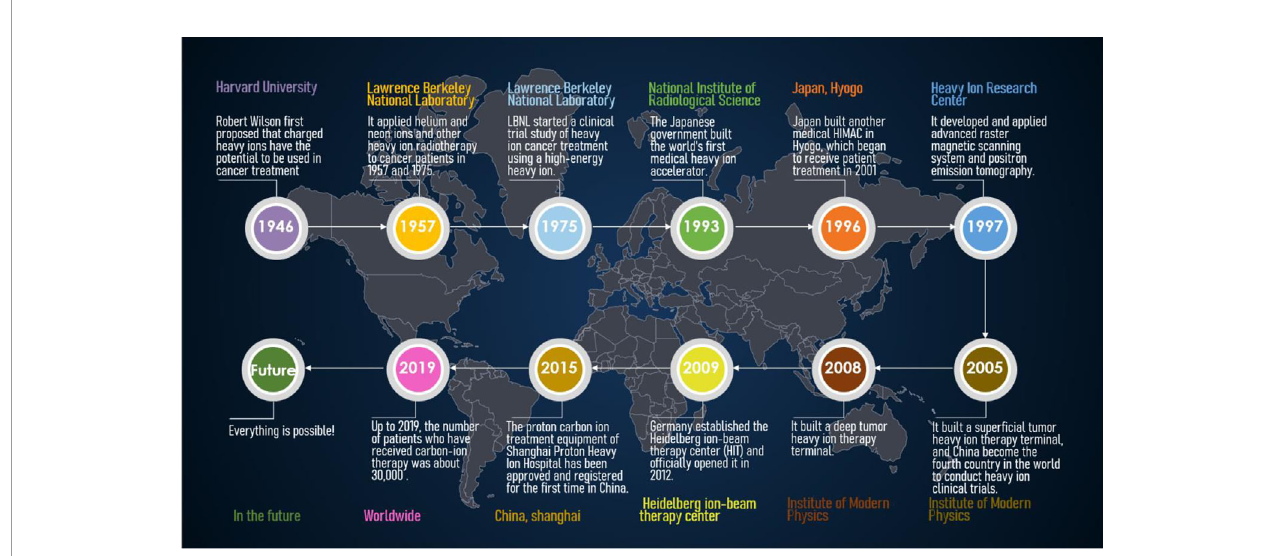
FIGURE 1 | Timeline of major events in heavy ion